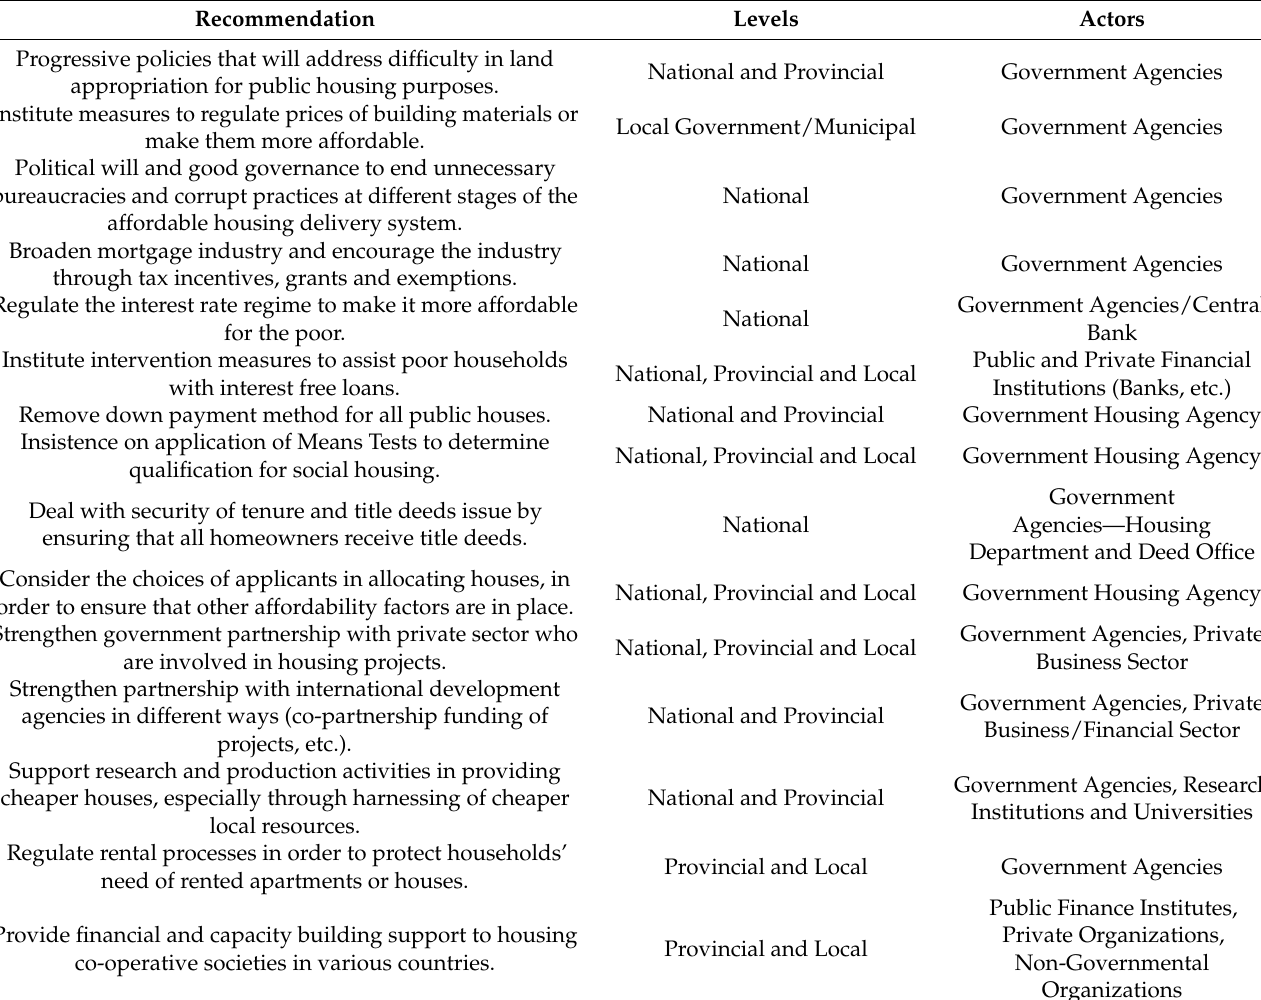
Table 3. Recommendations, levels and responsible implementing